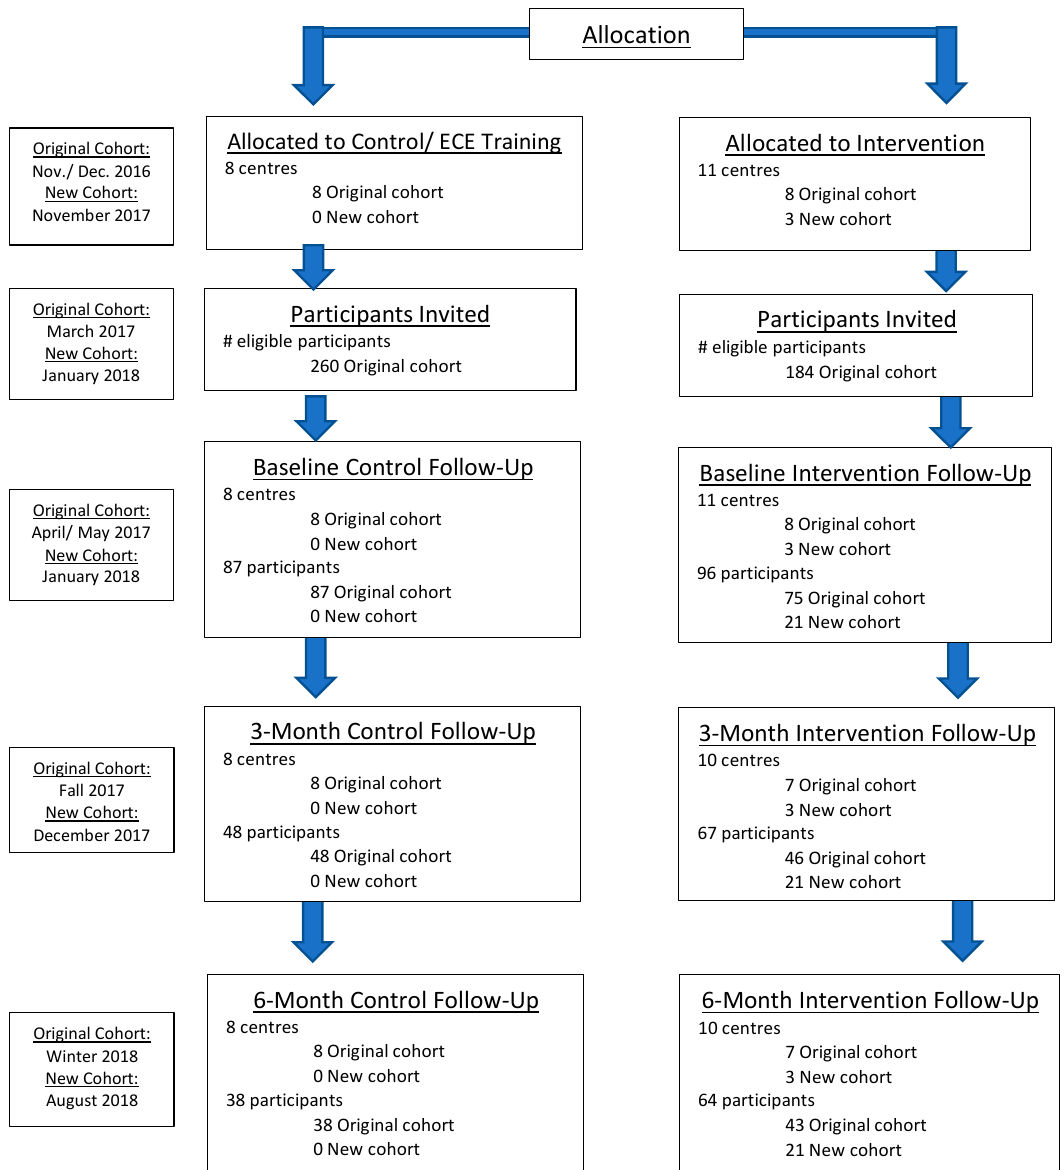
Figure 3. Flow diagram of participant numbers (children).